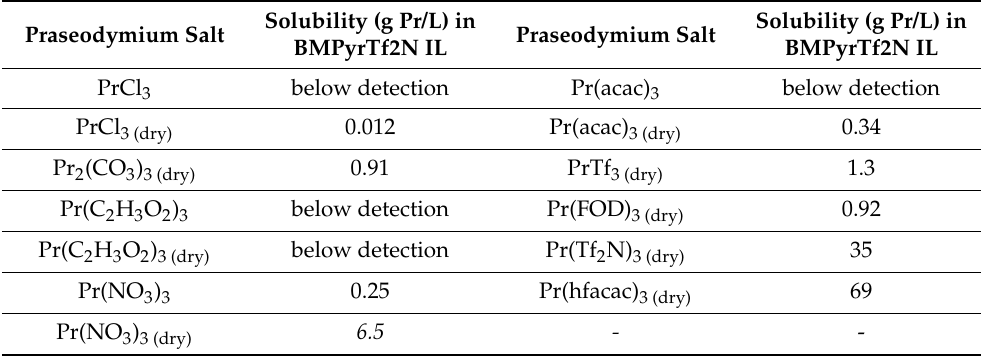
Table 1. Solubility of several Praseodymium salt compounds in 1-butyl-1-methylpyrrolidinium bis(trifluoromethylsulfonyl)imide at 25 °C .